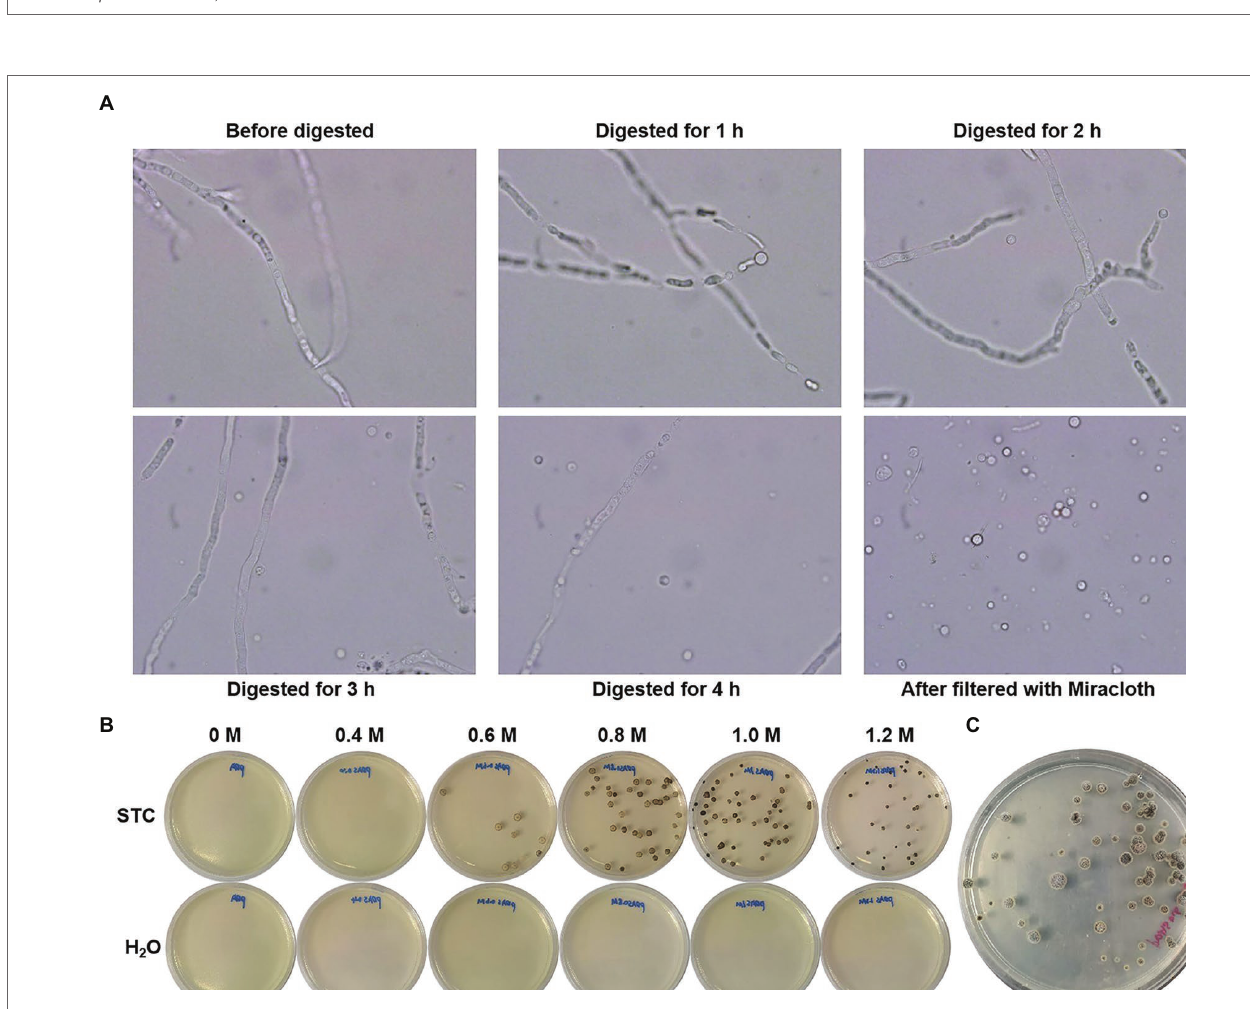
FIGURE 3 | Protoplast-mediated transformation. (A) Images of hyphae and protoplasts incubated in the enzyme solution (100 × objective lens). (B) Optimization of regeneration medium with different concentrations of D-sorbitol; STC: protoplasts were diluted with STC; H 2 O: protoplasts were diluted with H 2 O. (C) Original transformation plates of hph-sgfp